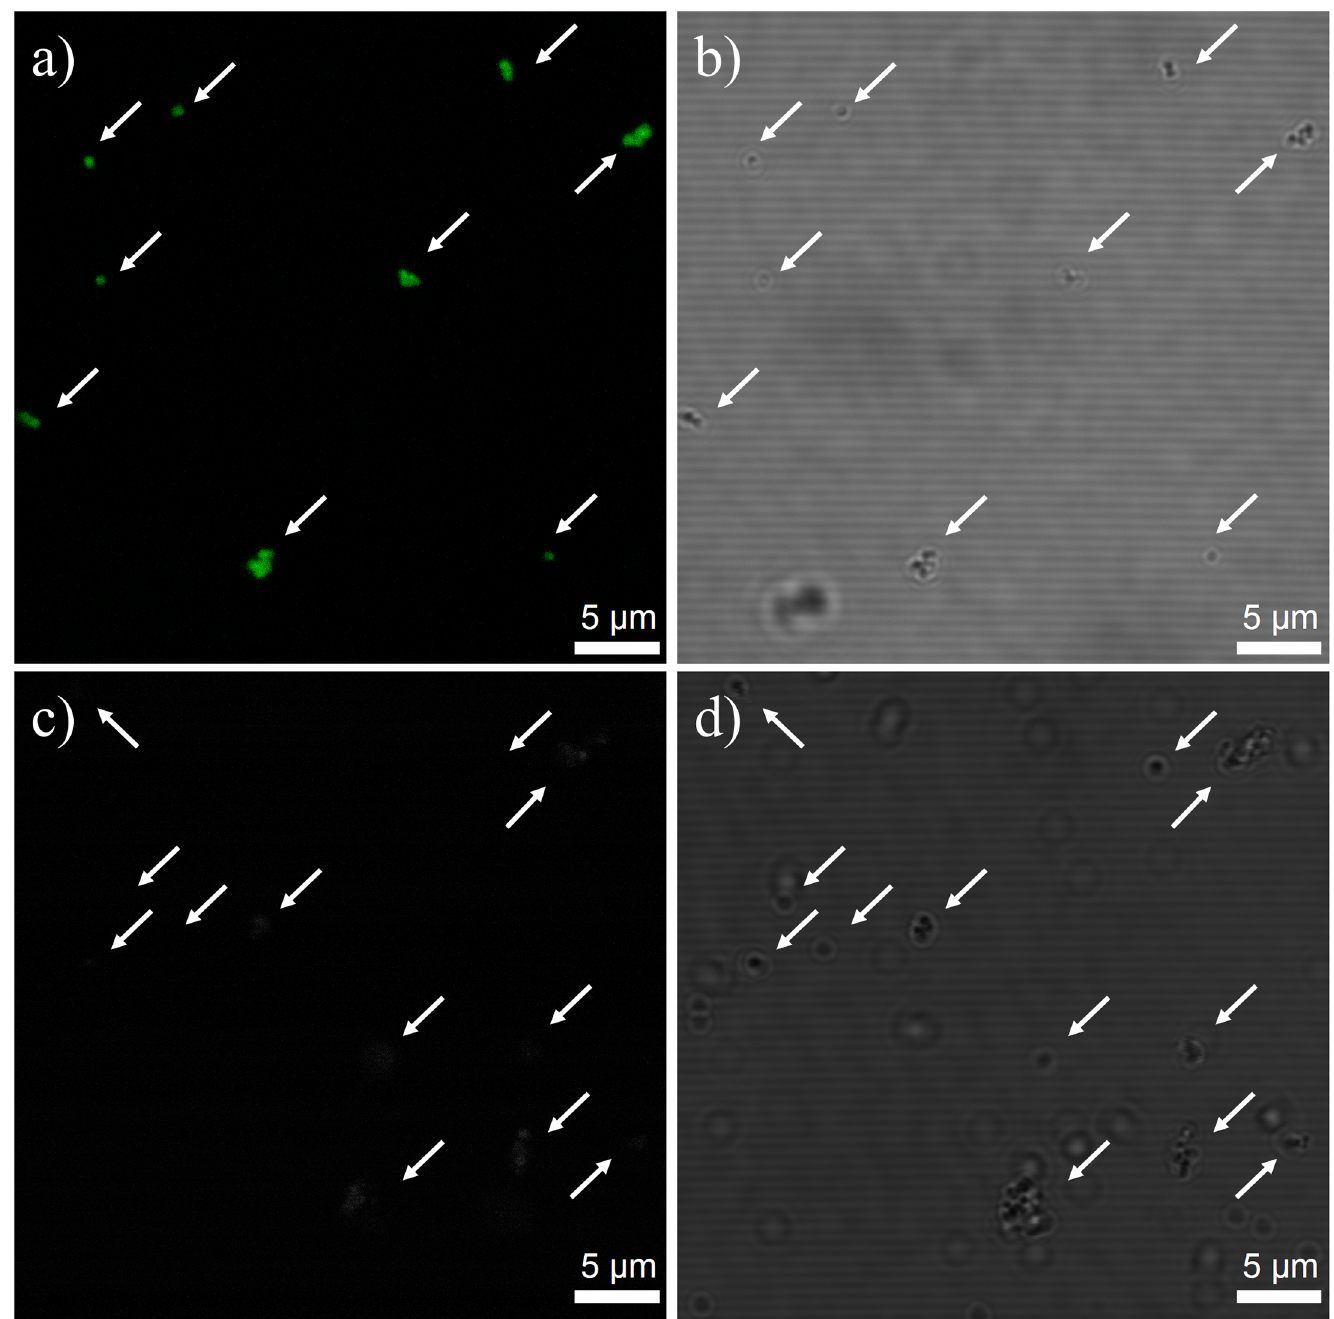
Fig 4. FITC-streptavidin separation using biotin-conjugated DL MNPs and bare DL MNPs. Fluorescence and optical microscopic images of (a, b) biotin- conjugated DL MNPs and (c, d) bare DL MNPs after incubation with FITC-streptavidin and magnet-induced separation. Arrows indicate the detected NPs.